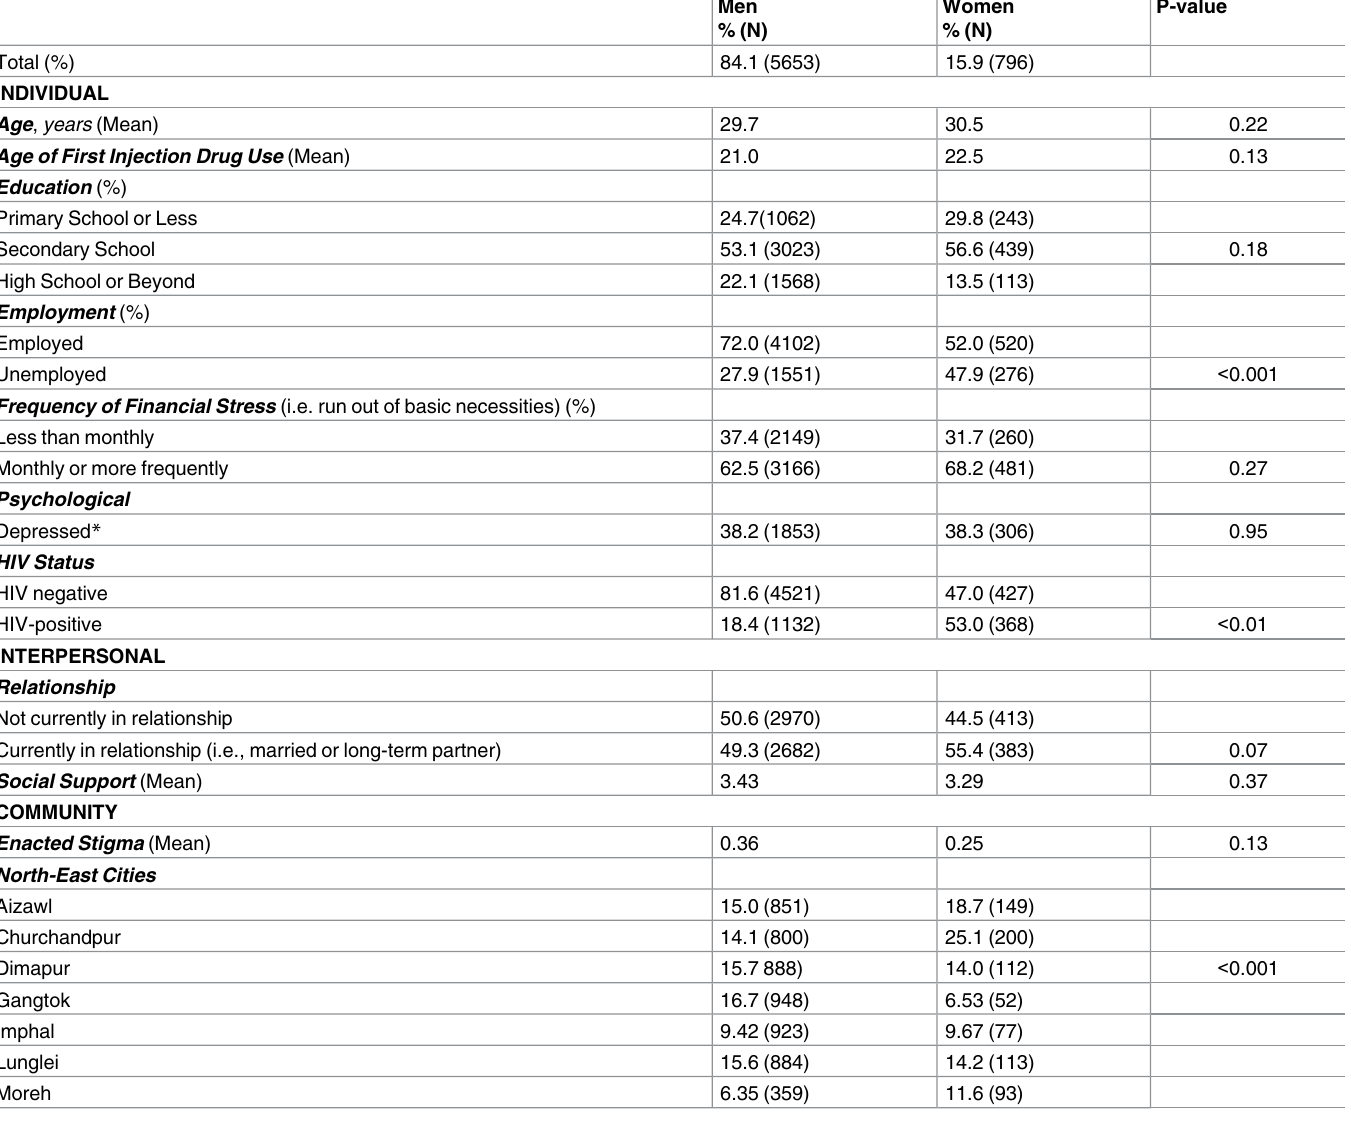
Table 1. Sample characteristics among men and women who inject drugs in seven cities in